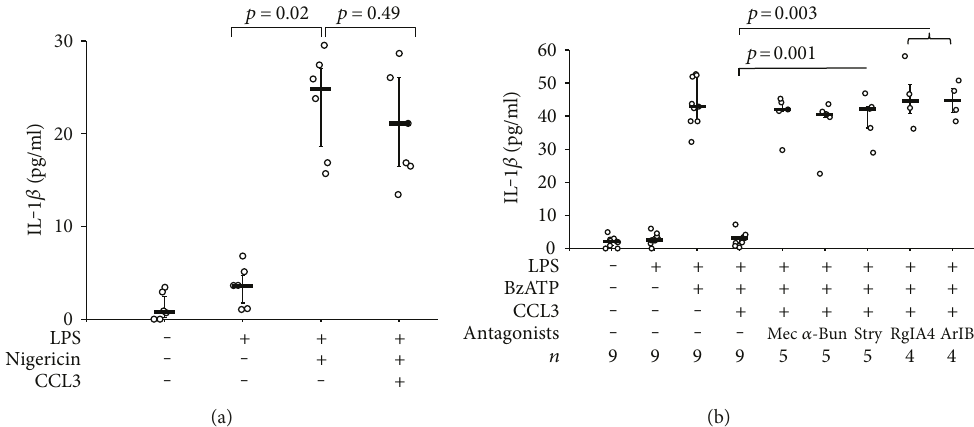
Figure 4: CCL3 signaling involves nicotinic acetylcholine receptors. Human monocytic U937 cells were primed with LPS (1 μ g/ml, 5h) and activated (a) with the pore-forming bacterial toxin nigericin (50 μ M) or (b) with 2 ′ (3 ′ )-O-(4-benzoylbenzoyl)adenosine-5 ′ -triphosphate (BzATP; 100 μ M, 30 min). The release of IL-1 β to the cell culture supernatant was measured by ELISA. (a) Nigericin induced the release of IL-1 β by LPS-primed U937 cells, but the chemokine CCL3 (10 ng/ml) did not impair the nigericin-triggered release of IL-1 β ( n = 6 ). (b) Nicotinic antagonists mecamylamine (Mec; 100 μ M), α -bungarotoxin ( α -Bun; 1 μ M), and strychnine (Stry; 10 μ M), as well as α -conotoxins ArIB [V11L,V16D] (200nM) and RgIA4 (200nM), reversed the inhibitory e ff ect of CCL3. Data are presented as individual data points, bars indicate median, and whiskers percentiles are 25 and